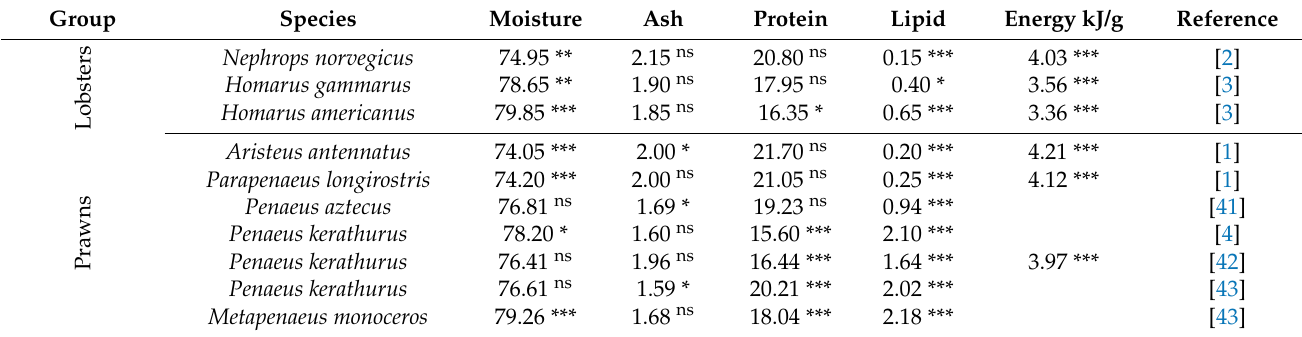
Table 2. Proximate composition (percentage of wet weight), of decapod crustacean species in the Mediterranean, or imported live, and statistical comparison with values estimated for the European spiny lobster ( Palinurus elephas ). Data are mean values. Significance level (ns: non-significant, *: p < 0.05, **: p < 0.01, ***: p < 0.001). Group